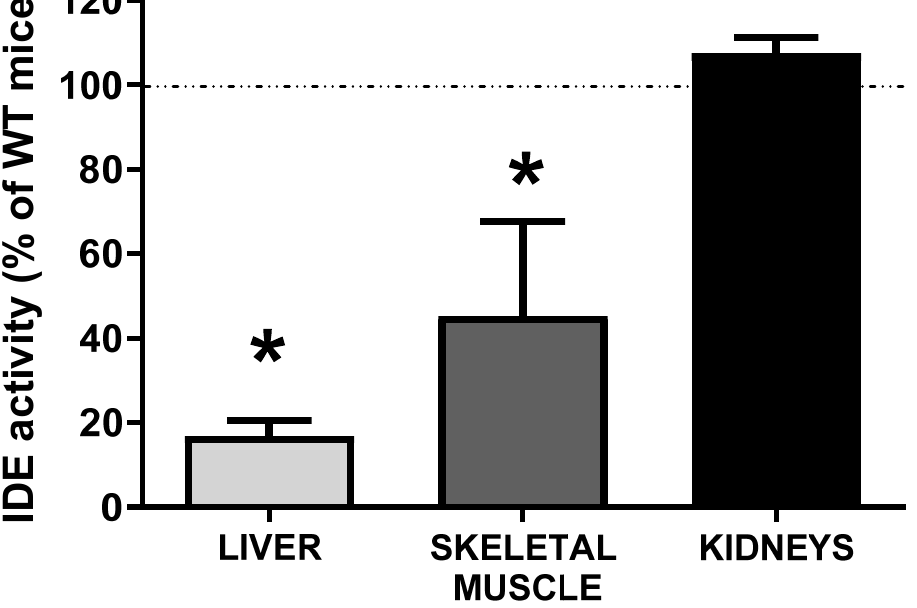
Figure A4. IDE activity in liver, skeletal muscle, and kidneys from WT and IDE-KO mice. Tissue extracts from WT and IDE-KO mice were prepared and assessed for IDE activity. Significance is indicated as relative to the corresponding values of IDE activity in WT mice. Data are the means ± SEM of 3 independent experiments. * p < 0.05 vs. WT by ANOVA.